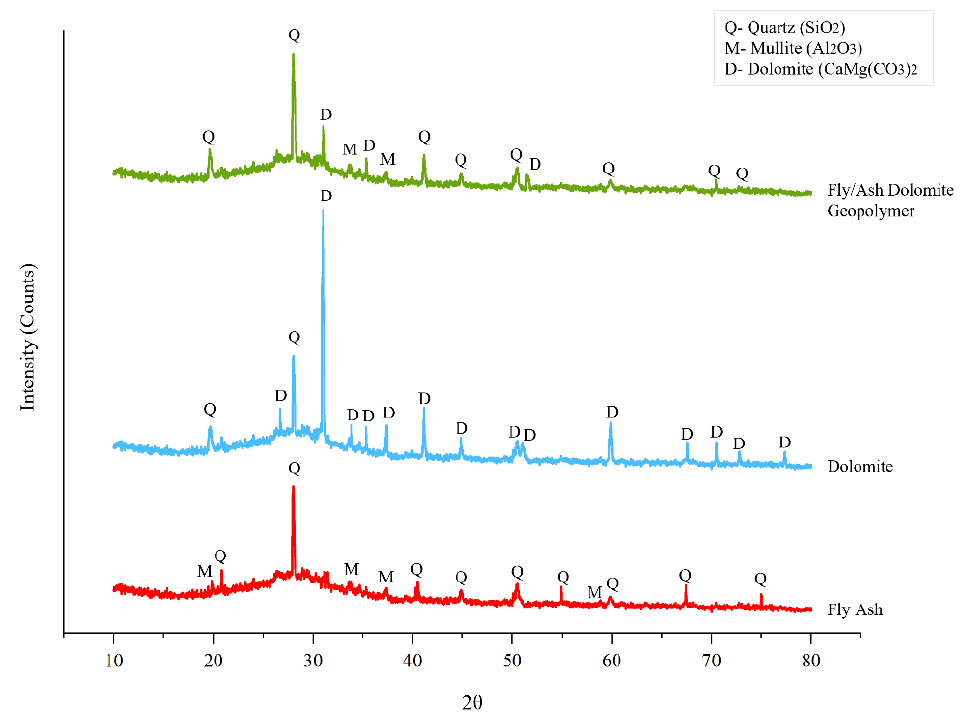
Figure 12. XRD patterns of fly ash, dolomite and fly ash/dolomite geopolymer. The highest peak observed on fly ash was quartz meanwhile on dolomite it was the dolomite phase. The combination both of materials that produce a geopolymer after being activated by alkaline solutions at 8 M NaOH concentration created a high phase of quartz and dolomite. There is a huge “amorphous hump” that rises between 20 ◦ to 40 ◦ degrees 2 θ which is illustrative of a geopolymeric reaction. From the XRD patterns of fly ash, the peaks indicate quartz (SiO 2 ) (ICDD: 00-0461-045) as a major crystalline peak at 2 θ values of 27.993 ◦ . Less intense quartz was also ob- served at 2 θ values of 20.836 ◦ , 40.479 ◦ , 44.484 ◦ , 50.535 ◦ and 67.42 ◦ . The peak of mullite (3 Al 2 O 3 (2 SiO 2 )) (ICDD 00-015-0776) was obtained at 19.835 ◦ , 33.85 ◦ , 35.296 ◦ and 58.877 ◦ . According to the findings of Thamer Alomayri [38], amorphous aluminosilicates alone in fly ash are reactive in the geopolymer formation process. Aside from that, the crystalline phases with primary peaks of the dolomite raw sample were indexed with the dolomite (CaMg(CO 3 ) 2 ) (ICDD 00-036-0426) reference pattern at 2 θ values of 31.002 ◦ , 28.022 ◦ , 33.85 ◦ , 35.296 ◦ , 37.365 ◦ , 41.080 ◦ , 50.513 ◦ and 59.879 ◦ . Geopolymerization reaction requires Si and Al which are mainly detected in this phase analysis. Therefore, the quartz phase exhibited as a major mineral shows a significant peak for fly ash/dolomite geopolymer at 2 θ values of 27.993 ◦ , 19.612 ◦ , 41.105 ◦ and 50.446 ◦ which shows the availability of Si in the geopolymer system that mainly came from the fly ash. Meanwhile, the mullite phase as minor minerals was also observed at peak 2 θ values of 33.583 ◦ and 37.365 ◦ . In line with Saliha Alehyen et al., the mullite phase or alumina silicate shows the availability of amorphous silica and alumina in the fly ash/dolomite geopolymer [39]. The dolomite phase was also detected in the fly ash/dolomite